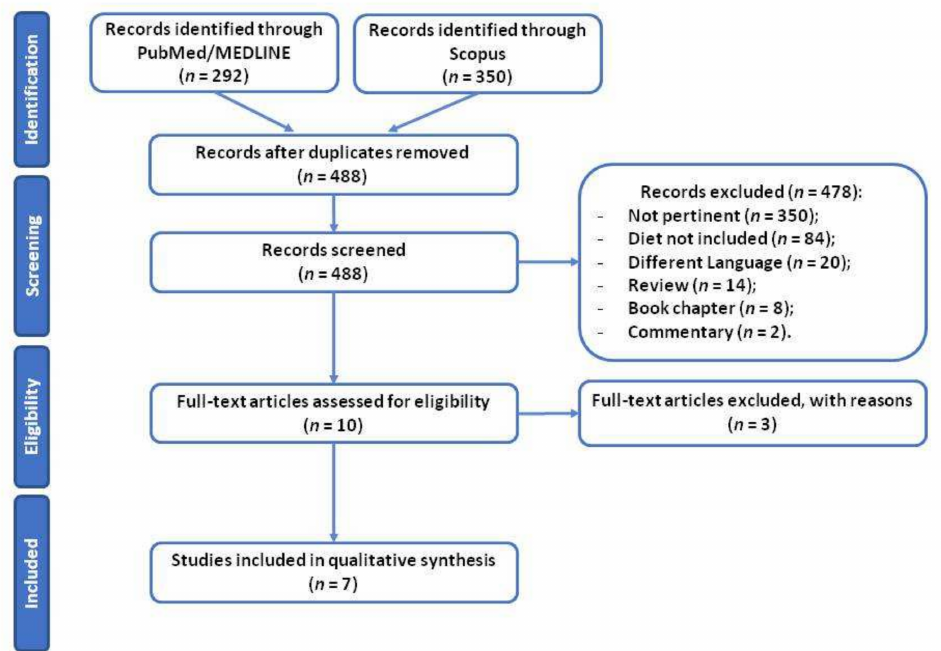
Figure 1. Flowchart representing the PRISMA flow diagram of the screening and selection of the